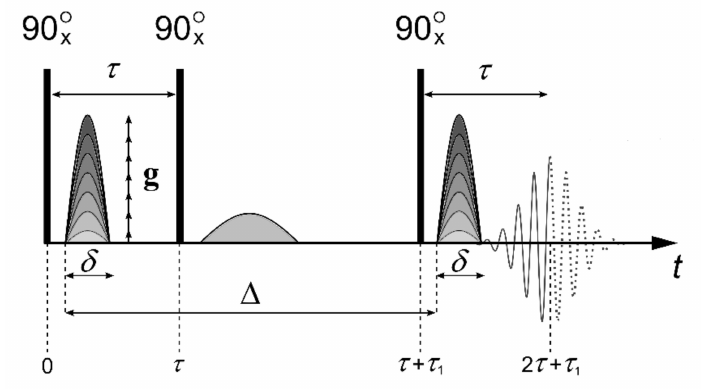
Figure 1. Stimulated echo pulse sequence with the magnetic field gradient